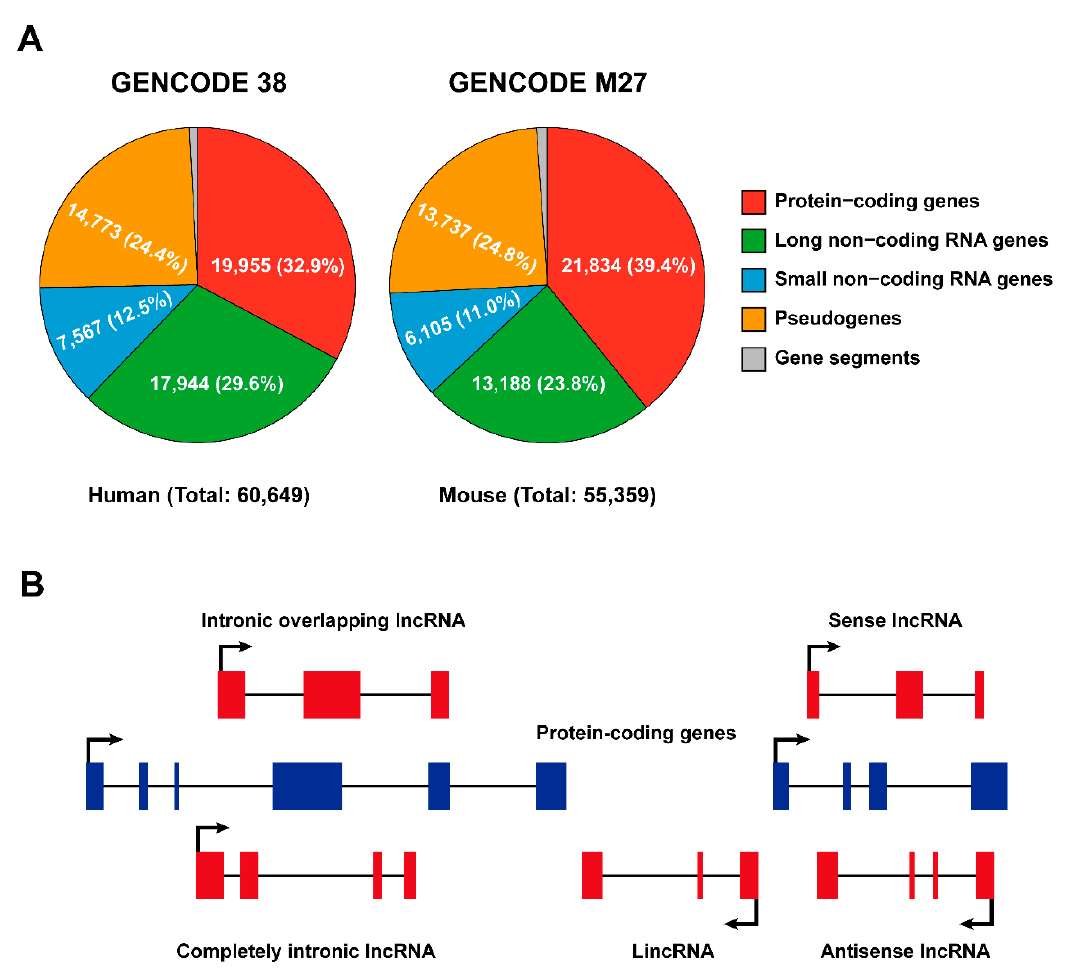
Figure 1. Classification of long non-coding RNAs. ( A ) Pie charts illustrating numbers and percentages of protein- and non- coding genes in the human and mouse genomes (released from GENCODE, 2021 update; https://www.gencodegenes.org (accessed on 5 May 2021)). ( B ) Classification of lncRNAs based on their localization with respect to genomic protein-coding genes. Sense/antisense lncRNAs are transcribed in the same/opposite direction as protein-coding genes and overlap at least one coding exon; completely intronic lncRNAs are transcribed from the intron of a protein-coding gene; intronic overlapping lncRNAs contain intronic sequences; lincRNAs are transcribed from regions between two protein-coding gene loci.